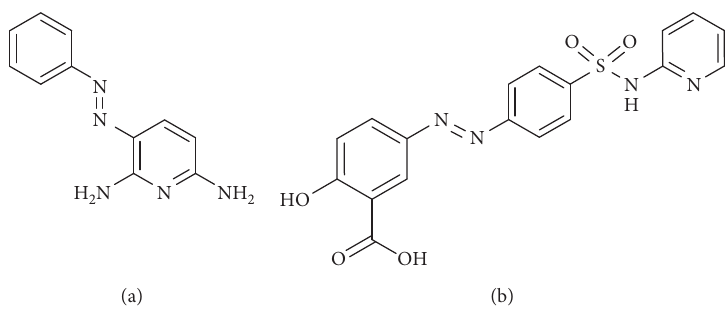
Figure 1: Chemical structures of current azo-based drugs: (a) phenazopyridine and (b)